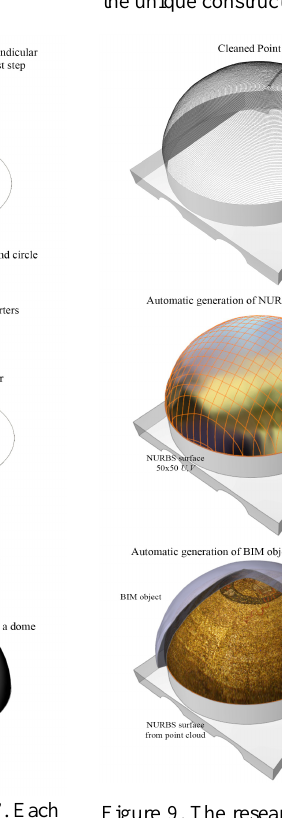
Figure 9. The research method: ‘how to model a dome by GOG 10’. The modelling procedures bridge the gap between NURBS modelling and BIM